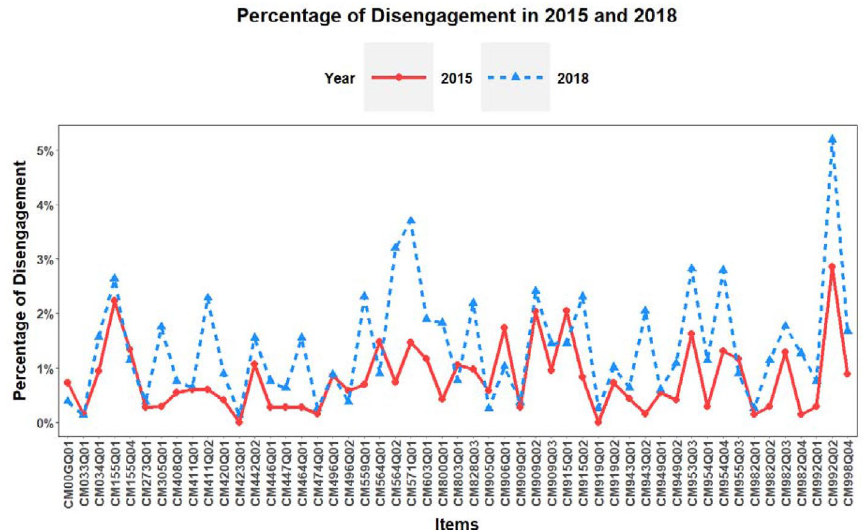
Fig. 1 Percentage of disengagement in 2015 and 2018. Source: Organisation for Economic Co-operation and Development (OECD), Programme for International Student Assessment (PISA), 2015 and 2018 Mathematics